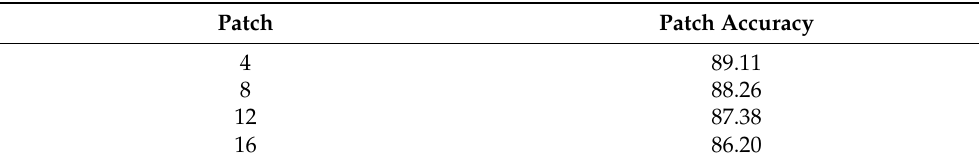
Table 8. The number of patches of local features. When we increased the number of patches, our experimental accuracy did not increase but decreased. Finally, we found that the effect was best when the number of patches was 4.